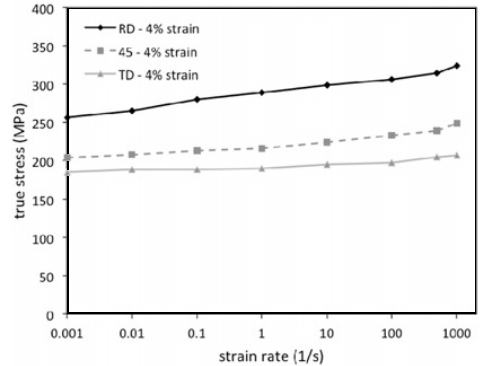
Fig. 10. E ff ect of orientation on power law hardening parameters for ZEK100 sheet at a strain rate of 0 . 1s − 1 .